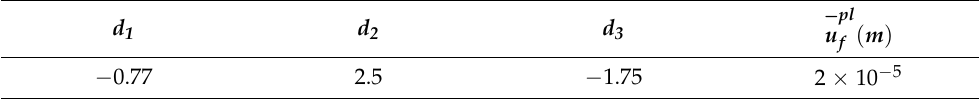
Table 3. Calibrated damage evolution law parameters for